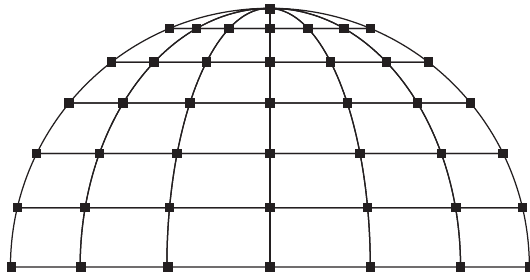
Figure 2: Distribution of